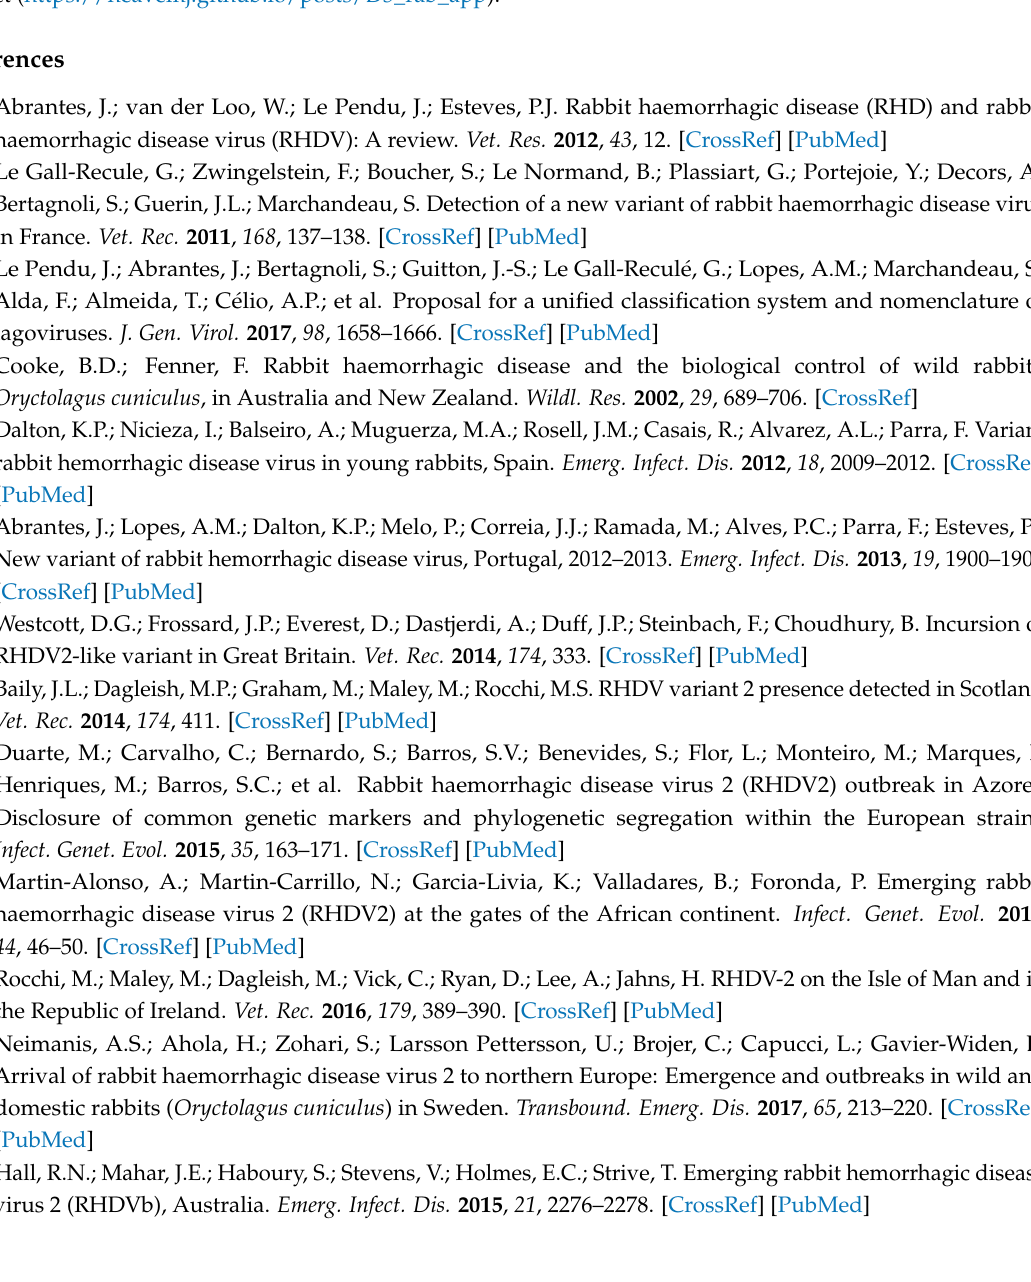
Figure S1: Read coverage of the GI.1 and GI.2 genomes, Figure S2: Significantly differentially expressed genes in infected rabbits compared to controls. Figure S3: Expression of genes in the “pink” co-expression module and change in selected genes over time. Table S1: The top 10 most differentially expressed genes in GI.2-infected rabbits. Table S2: Significantly enriched Gene Ontology (GO) terms in the category “Biological Process” for up regulated genes in GI.2-infected